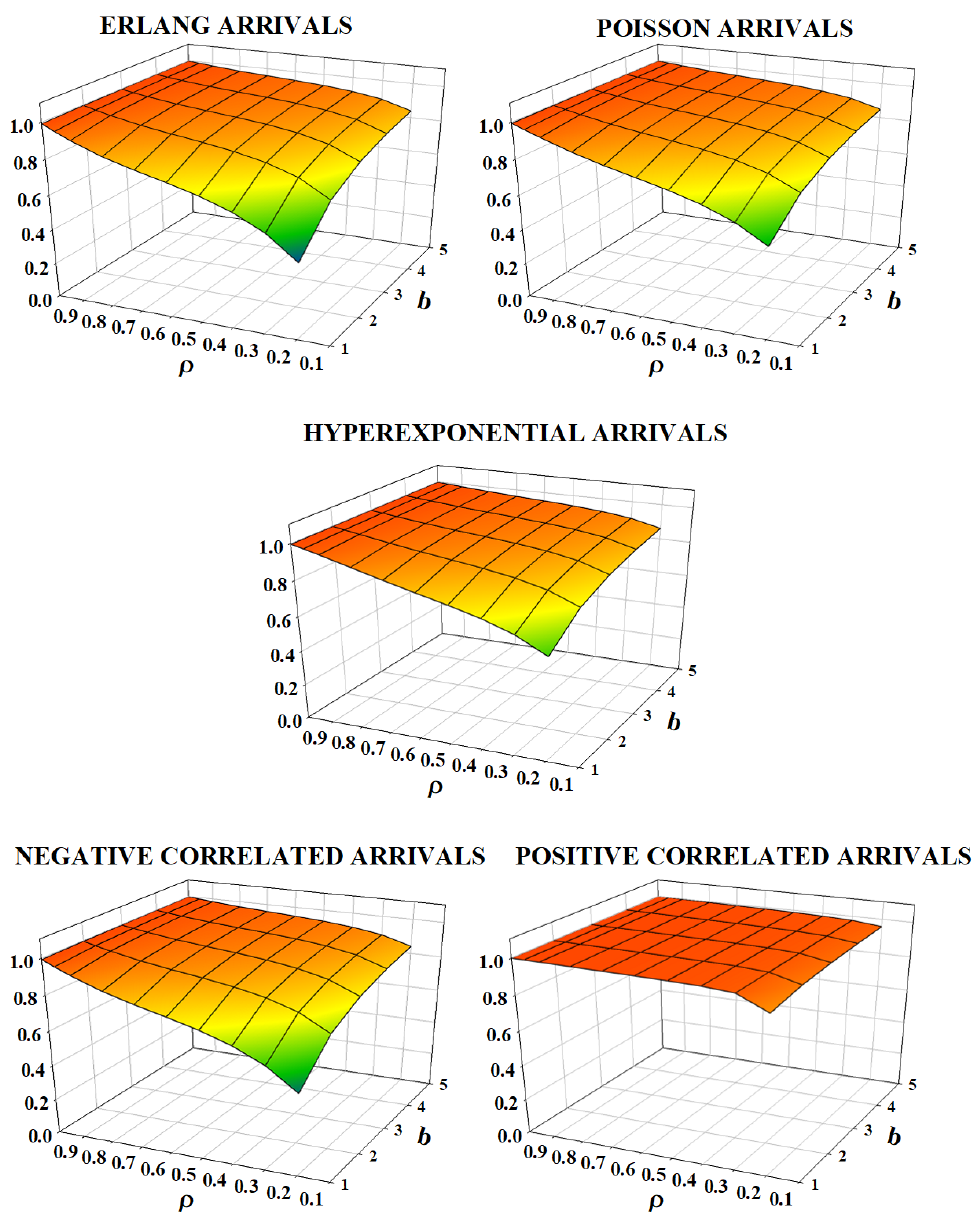
Figure 14. Spectral radius ( η ) for example